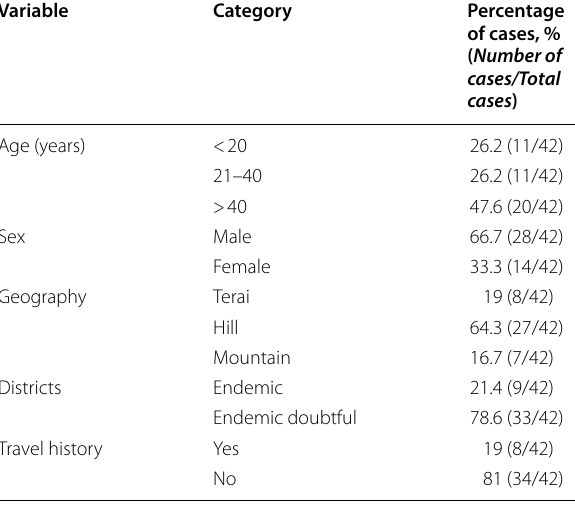
Table 1 Demographic findings of cutaneous leishmaniasis patients in Nepal,